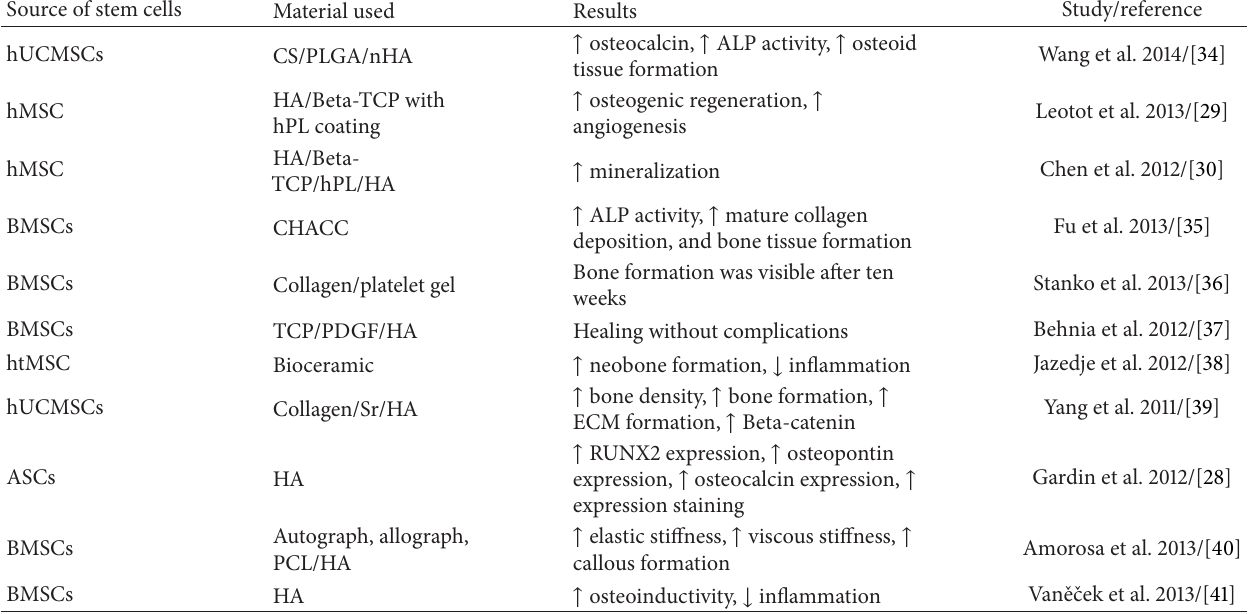
Table 4: Summary of references for recent advances in skeletal disease/injury